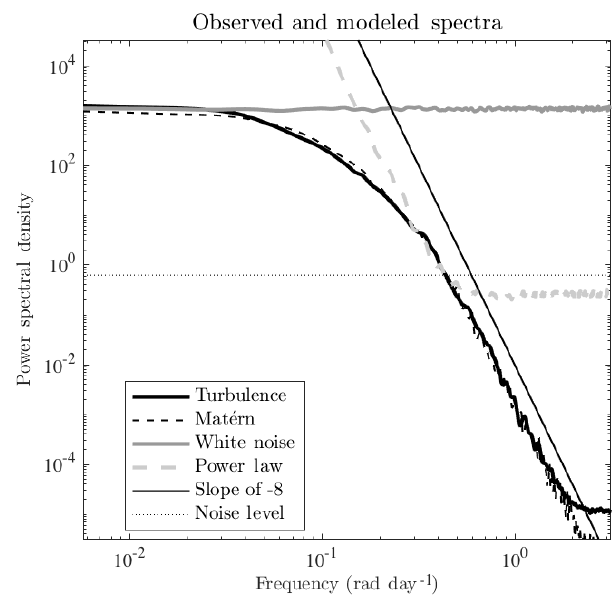
Figure 3. Spectra for the trajectories shown in Fig. 2. Estimated ro- tary spectra S zz (ω) are shown for positive frequencies only, since the negative frequency side is statistically identical. The first four curves show the mean values of the estimated spectra, formed as described in the text, of each of the four sets of trajectories shown in Fig. 2. The fifth curve, indicated by a solid line, shows a slope of − 8, corresponding to a slope parameter α = 4. The dotted horizon- tal line marks the approximately limit of double numerical precision for the power-law process, 15 orders of magnitude below its max- imum; this numerical precision limit accounts for the flattening of the gray dashed